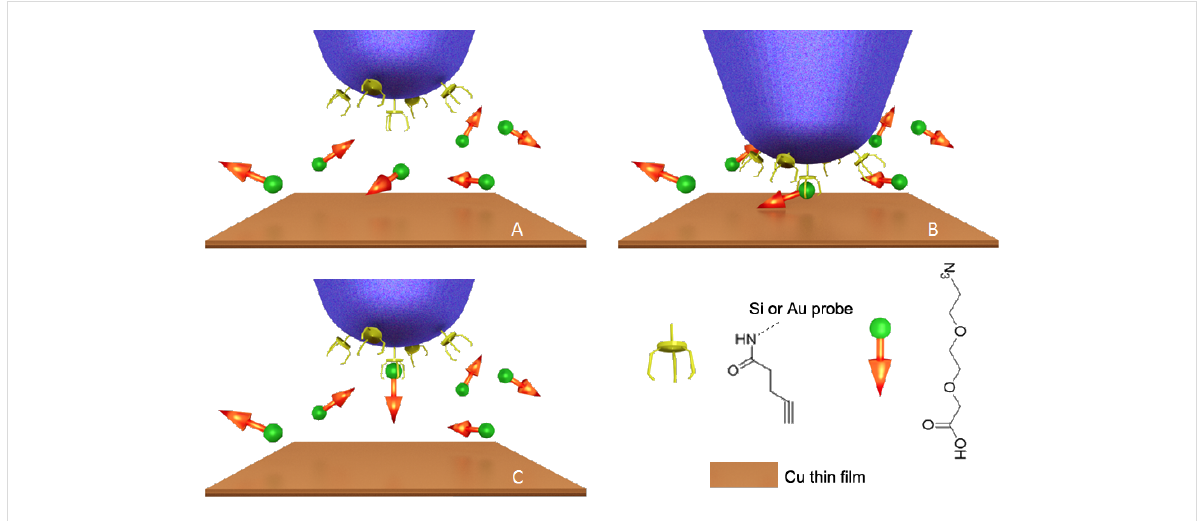
Figure 1: Schematic illustration of the functionalization of a single-molecule probe by using the ‘click’ reaction. (A) An alkyne-modified AFM probe is immersed in a solution of azide/carboxylic acid bi-functional molecules. (B) The probe is brought into contact with a substrate coated with a Cu film